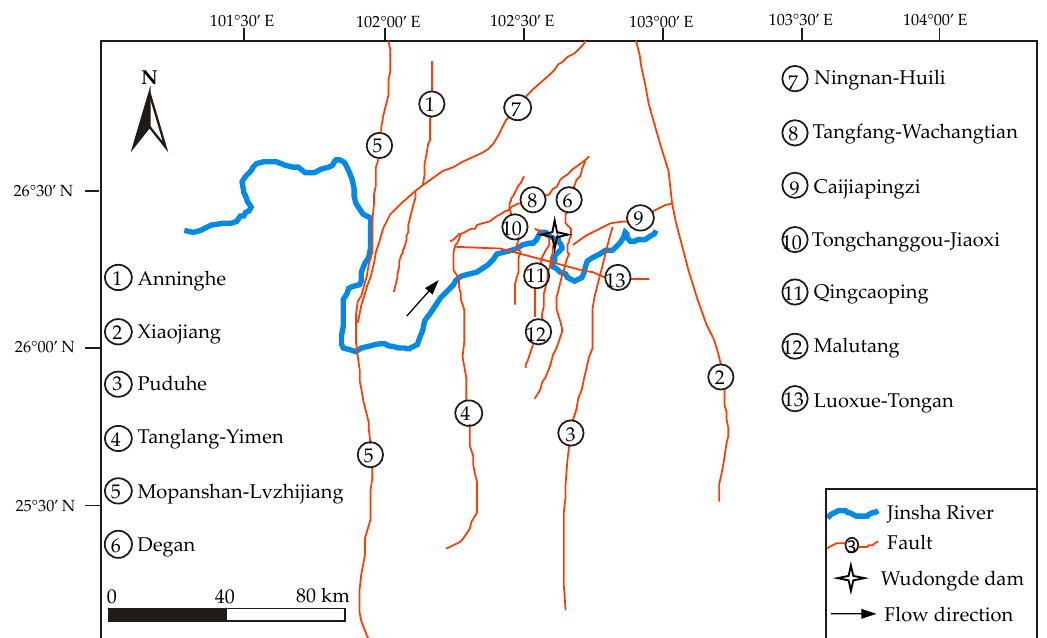
Figure 4. Regional tectonic framework map [33].